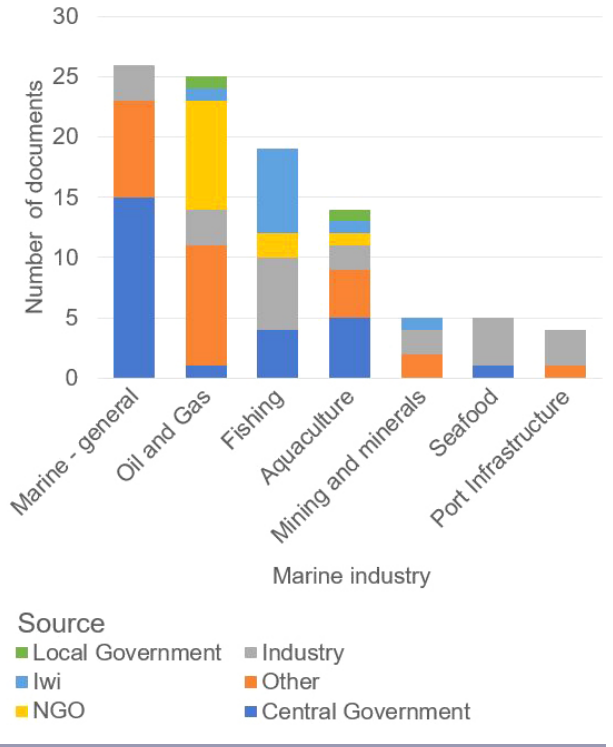
Fig. 2 . Number of documents published by different sources that refer to New Zealand’s marine industries, 2008–2017. Iwi = Indigenous M ā ori tribes of New